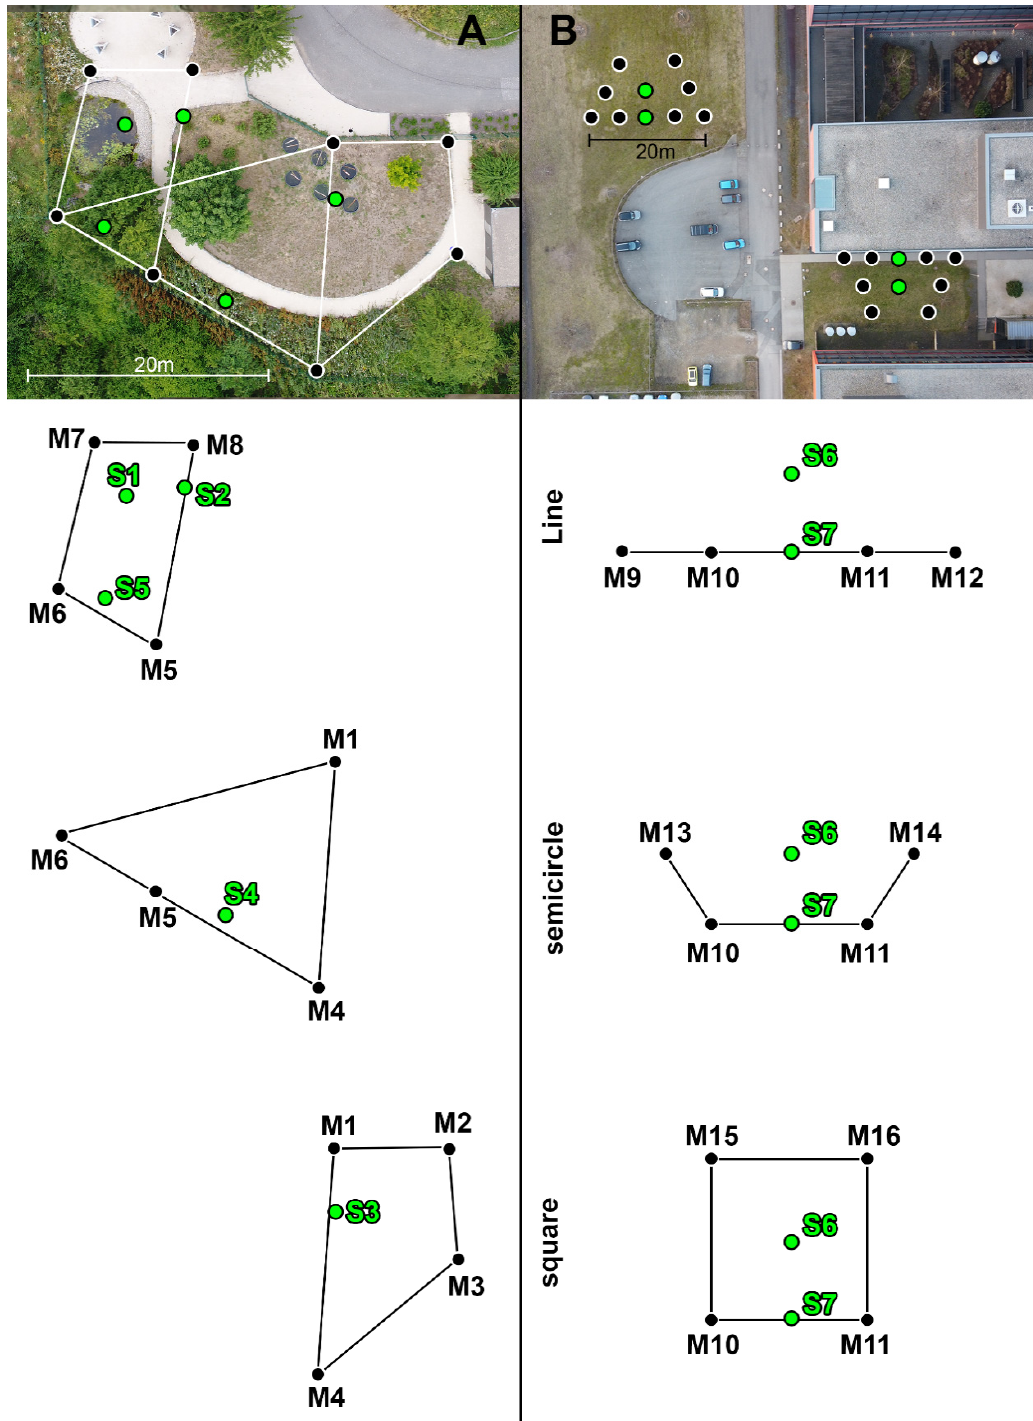
Figure 1. Microphone arrangement for Setup1 (environmental impact) ( A ) and Setup2 (artificial impact) ( B ). The black dots indicate the positions of the microphones M1–M16. The green dots indicate the positions where the Bluetooth speaker was set up and the test vocalizations (Figure 2) were played (S1–S7). ( A ) The microphones by means of which the corresponding position of the Bluetooth speaker is estimated are shown below the aerial image (S1/S2/S5 = M5–M8; S3 = M1–M4; S4 = M1, M4–M6). ( B ) The microphones used for the three different microphone arrangements (square, semicircle, line) are shown below the aerial image (square = M10, M11, M15, M16; semicircle = M10, M11, M13, M14; line = M9–M12).